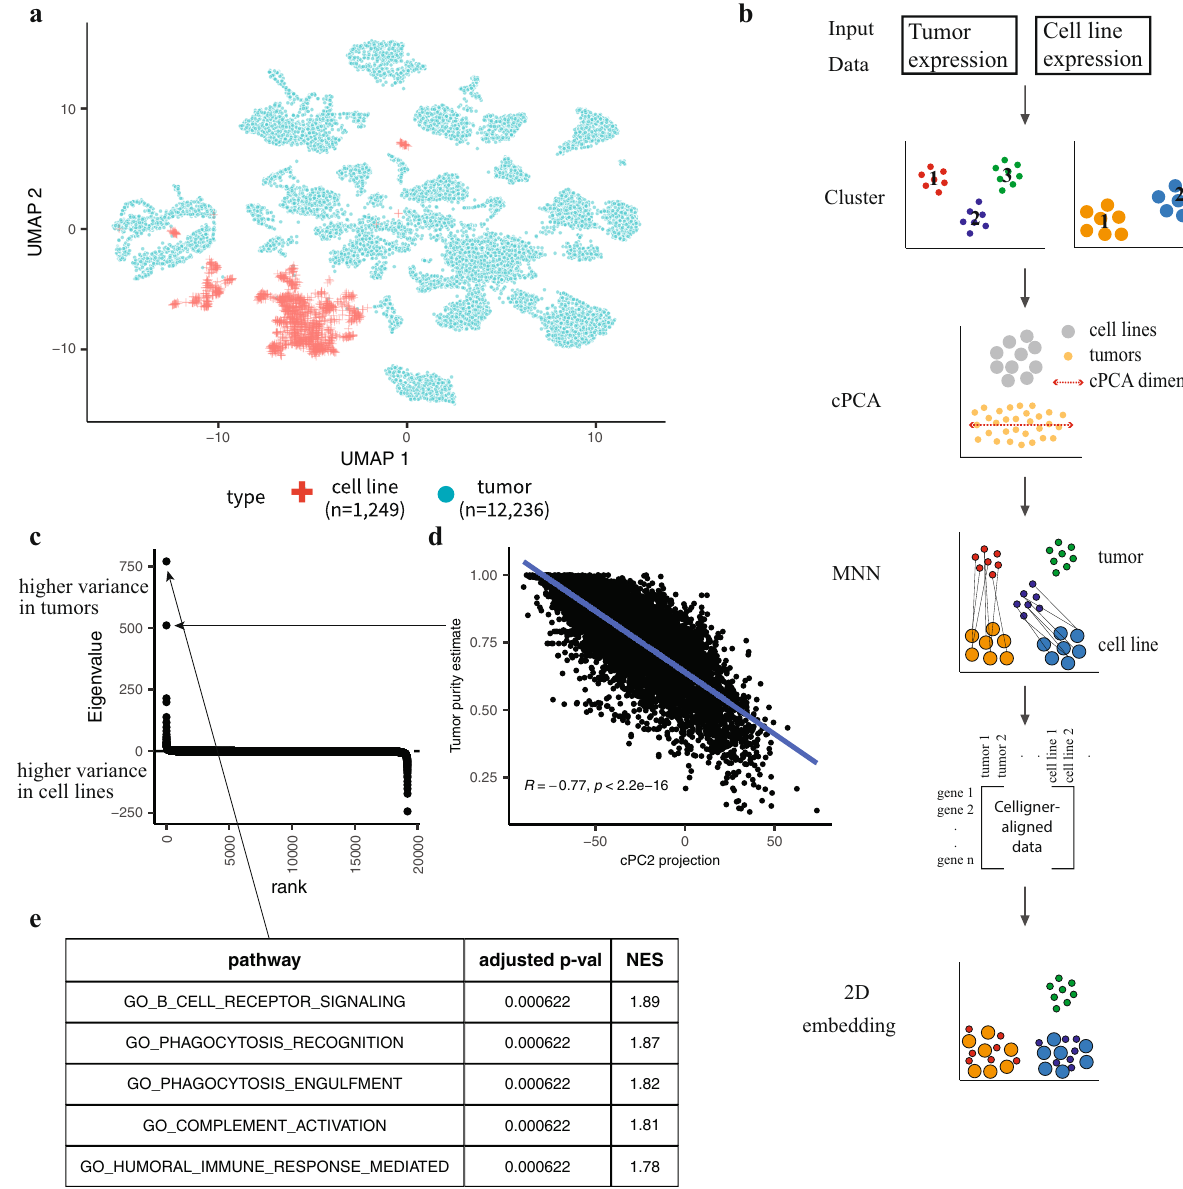
Fig. 1 Overview of the Celligner alignment method. a A 2D projection of combined, uncorrected cell line and tumor expression data using UMAP ( n = 1,249 cell lines, n = 12,236 tumors). b Method: Celligner takes cell line and tumor gene expression data as input, and fi rst identi fi es and removes expression signatures with excess intra-cluster variance in the tumor compared to cell line data using contrastive Principal Component Analysis (cPCA). Then Celligner identi fi es and aligns similar tumor-cell line pairs to produce corrected gene expression data, using mutual nearest neighbors (MNN) batch correction, which allows for improved comparison of tumors and cell lines. c cPC eigenvalues ordered by rank ( n = 19,188 eigenvalues). d Pearson correlation between the projection of tumor samples onto cPC2 and their estimated purity (using a consensus measurement of tumor purity 28 ) ( n = 7,832 tumors). e The top fi ve pathways from gene set enrichment analysis (GSEA) of cPC1. P-values are based on a gene-permutation test and adjusted using the Benjamini-Hochberg procedure (Methods, ‘ Gene set enrichment analysis ’